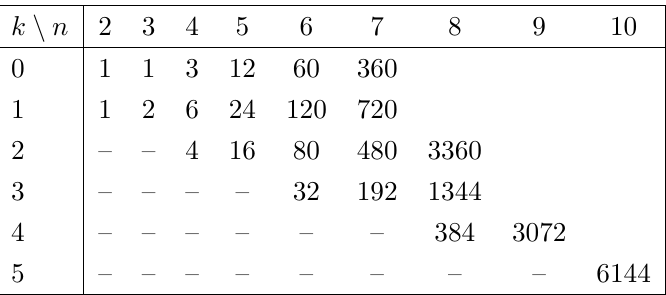
Table 2 . This table lists the size of the basis of primitive amplitudes, or equivalently the number of independent color factors for amplitudes with a gluonic or mixed loop. For the cases listed explicit checks have been done for the size of the basis, the number of independent color factors and the color decomposition. The variable n counts the total number of external particles and k denotes the number of quark-antiquark pairs. The numbers are explicitly given by 2 2 k (cid:0) 1 ( n (cid:0) 1)! k ! = (2 k